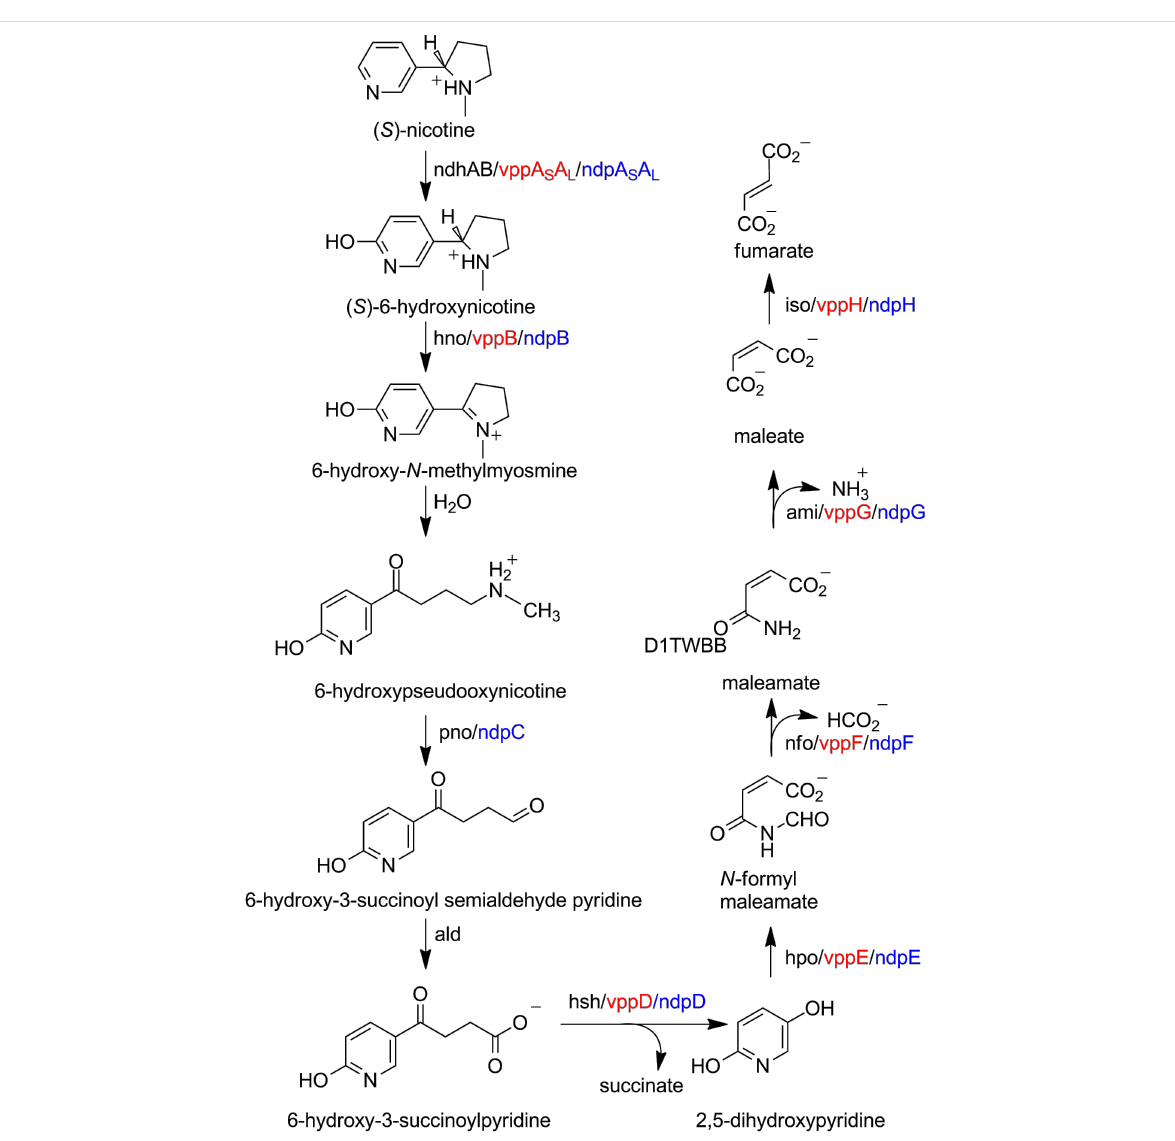
sp. SJY1, Sphingomonas melonis TY, and Shinella sp.